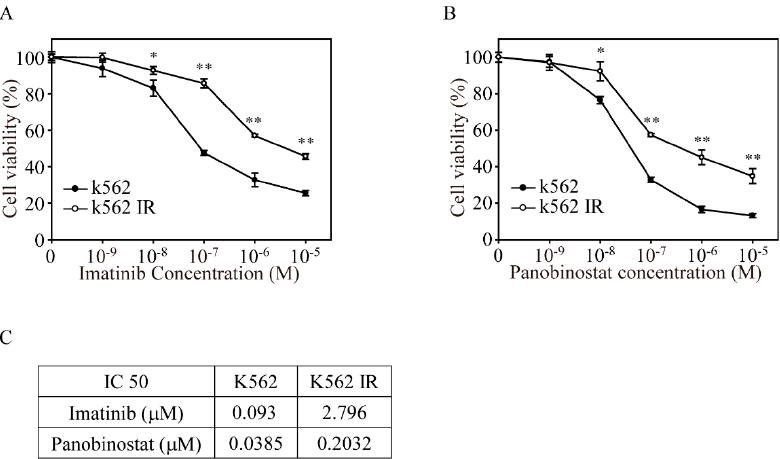
Figure 4. Panobinostat has anticancer effects on imatinib-resistant K562 cells. Both K562 and imatinib- 203 resistant K562 (K562-IR) cells were seeded overnight and treated with 0.001, 0.01, 0.1, 1 and 10 μ M of 204 ( A ) imatinib or ( B ) panobinostat for 24 h. The cells were assessed for cell viability by MTT